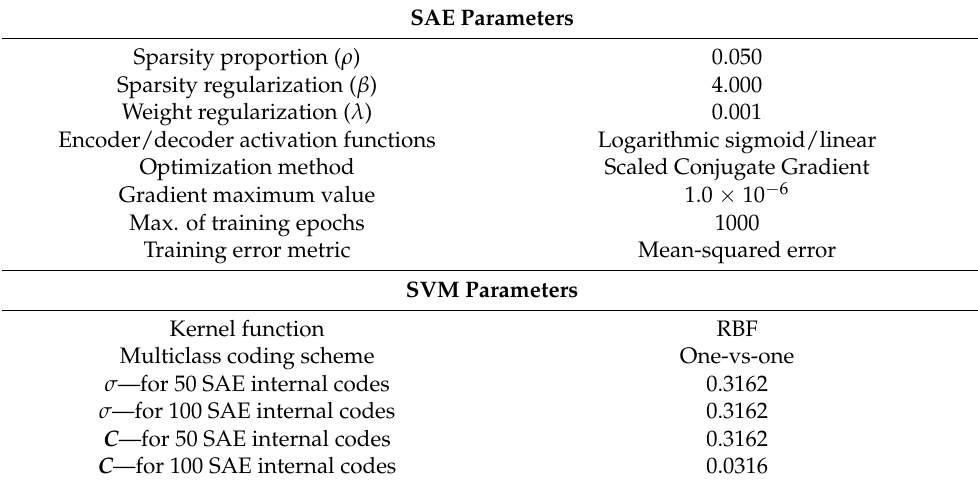
Table 5. SAE and SVM parameters of the proposed strategy for the V á rzea Nova